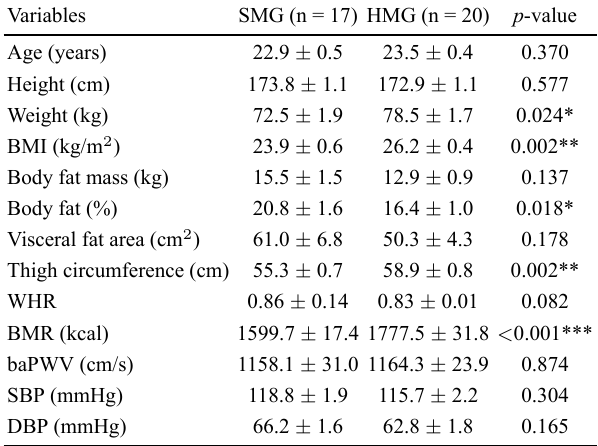
Table 2. Basic clinical characteristics of study